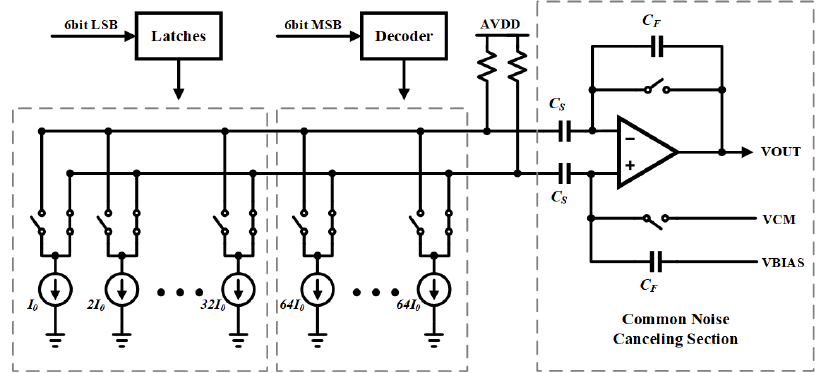
Figure 15. Block diagram of the ramp generator.